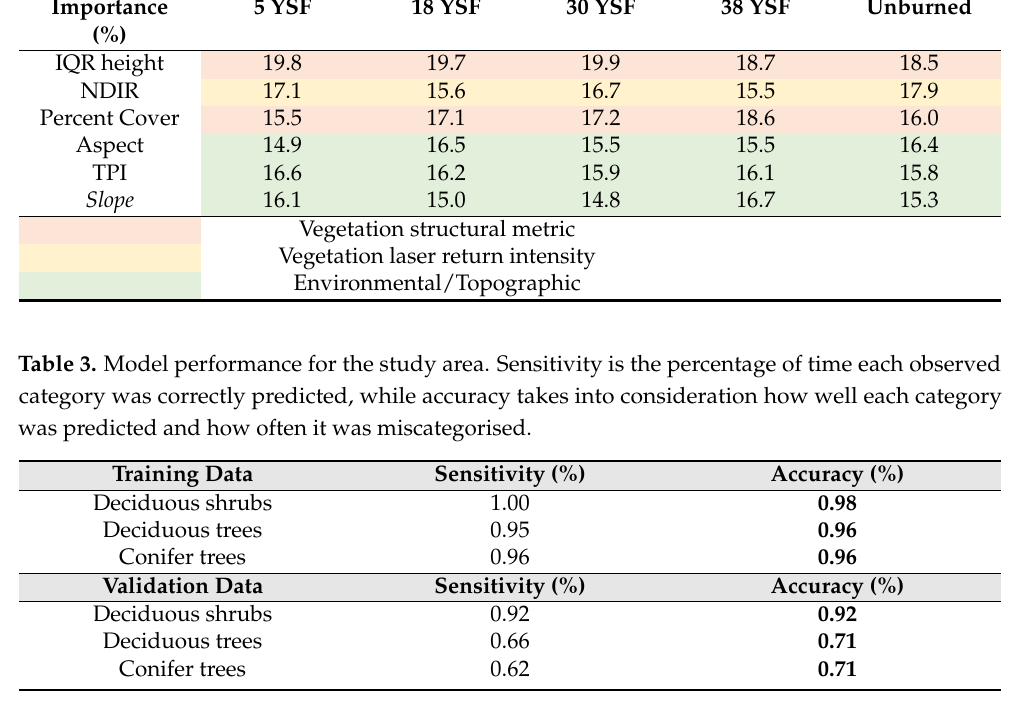
Table 4. Confusion matrix of forest-based regression between deciduous shrubs, deciduous trees, and conifers within burned and recently unburned peatlands.